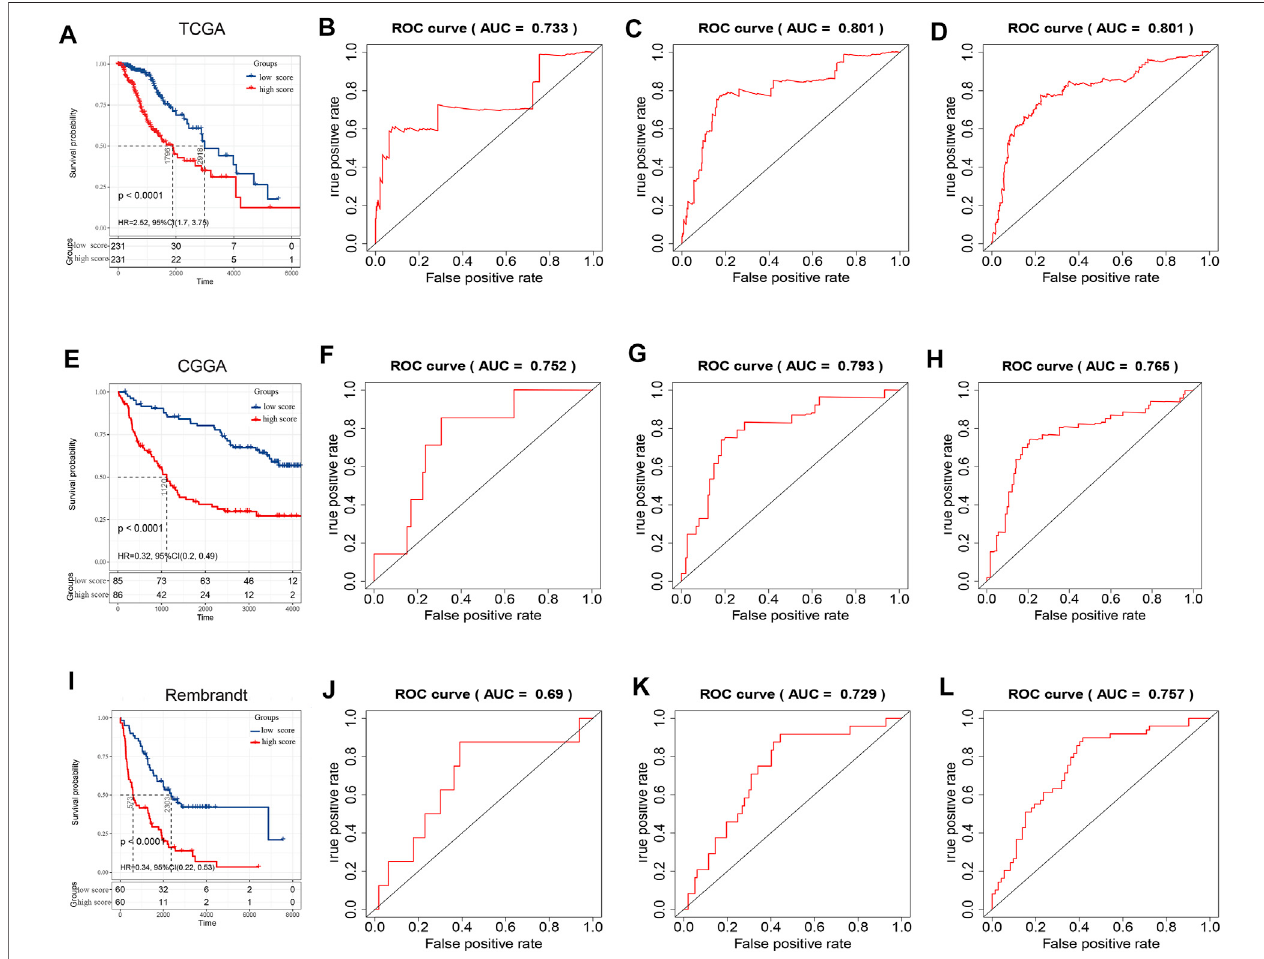
FIGURE 4 | Survival analysis and prognostic performance of risk score in LGG. Kaplan – Meier survival curves based on risk score in TCGA (A) , CGGA (E) , and Rembrandt cohorts (I) . 0.5-, 1-, and 3-years overall survival ROC curves based on risk score in TCGA (B – D) , CGGA (F – H) , and Rembrandt cohorts (J – L) .